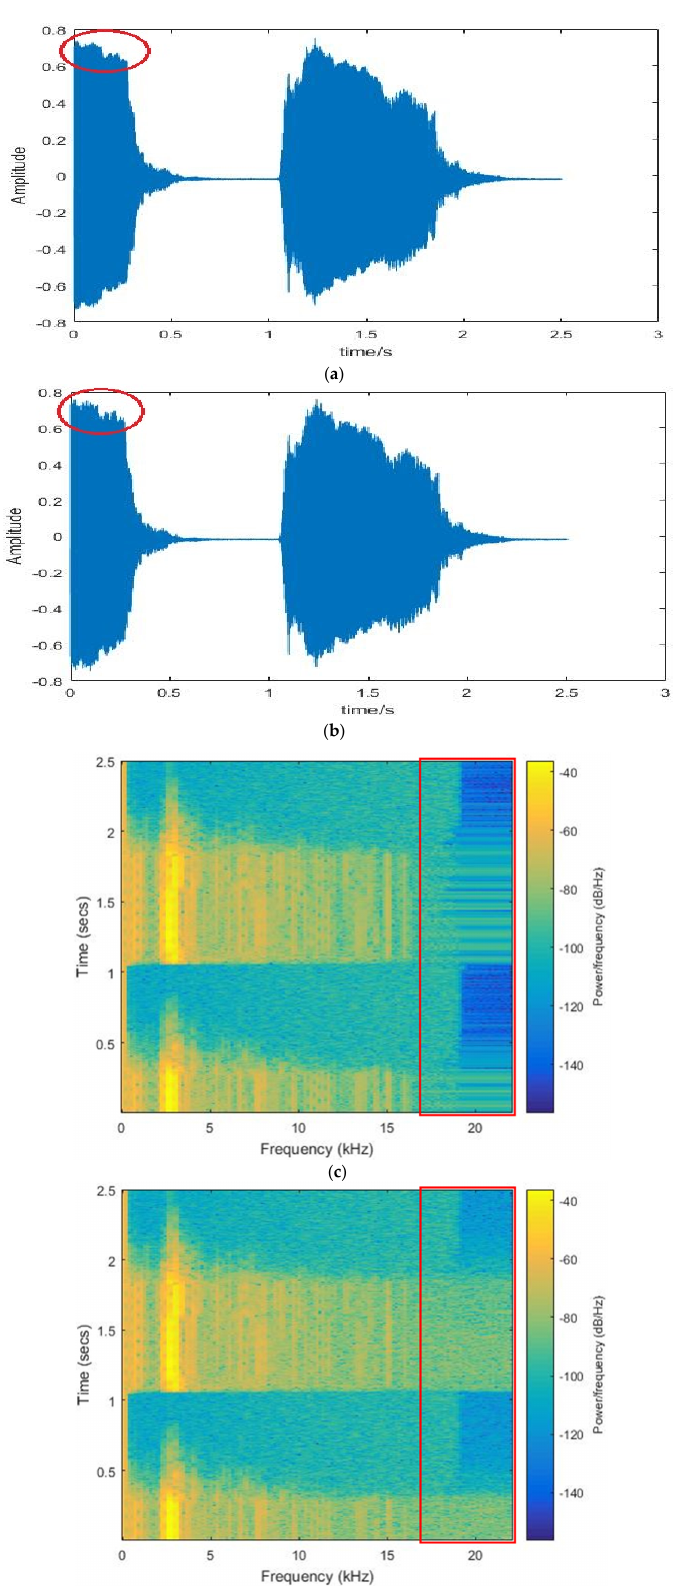
Figure 9. The influence of compression with the adaptive differential pulse code modulation (ADPCM). ( a ) The waveform of car horn before compression; ( b ) the waveform of car horn after compression; ( c ) the spectrograms of car horn before compression; ( d ) the spectrograms of car horn after compression.